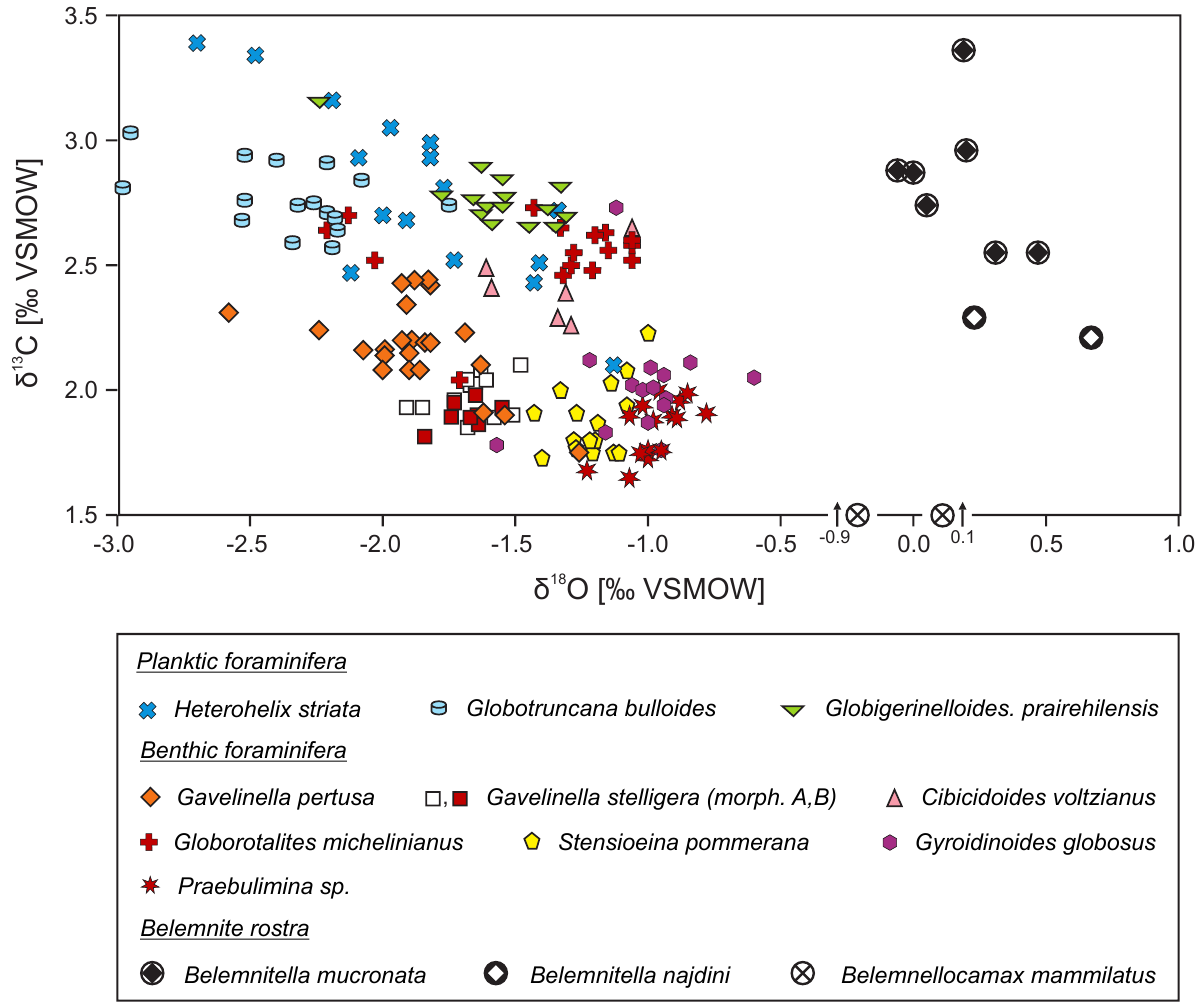
Figure 8. δ 18 O and δ 13 C values of individual benthic and planktic foraminifera tests and belemnitellid belemnite rostra from the Lower–Upper Campanian boundary (Upper Cretaceous, Mielnik, Eastern Poland; data of Bojanowski et al. [230] and Dubicka et al. [77]). Note a significant spread of foraminiferal δ 18 O values related to vital and habitat effects. Although high Gyroidinoides globosus and Praebulimina sp. δ 18 O values are expected to be close to isotope equilibrium (cf. [77]), ca. 1.0‰ higher belemnite δ 18 O values may show different point of oxygen isotope equilibrium or specific oxygen isotope fractionation in the rostra from the Belemnitellidae belemnite